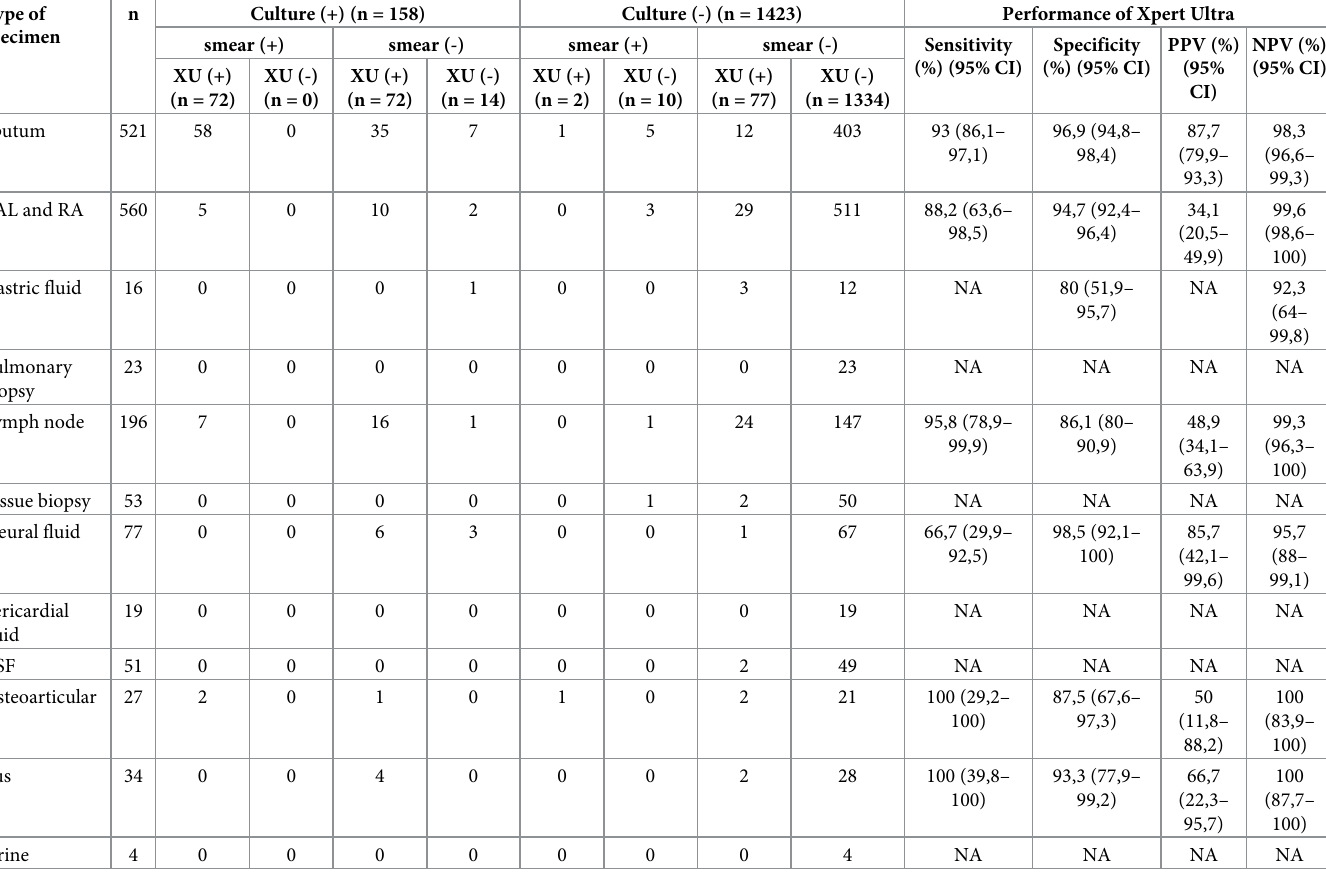
Table 1. Results by specimen type of MTB c culture, smear microscopy, Xpert Ultra and diagnostic performance of Xpert Ultra with culture as the reference